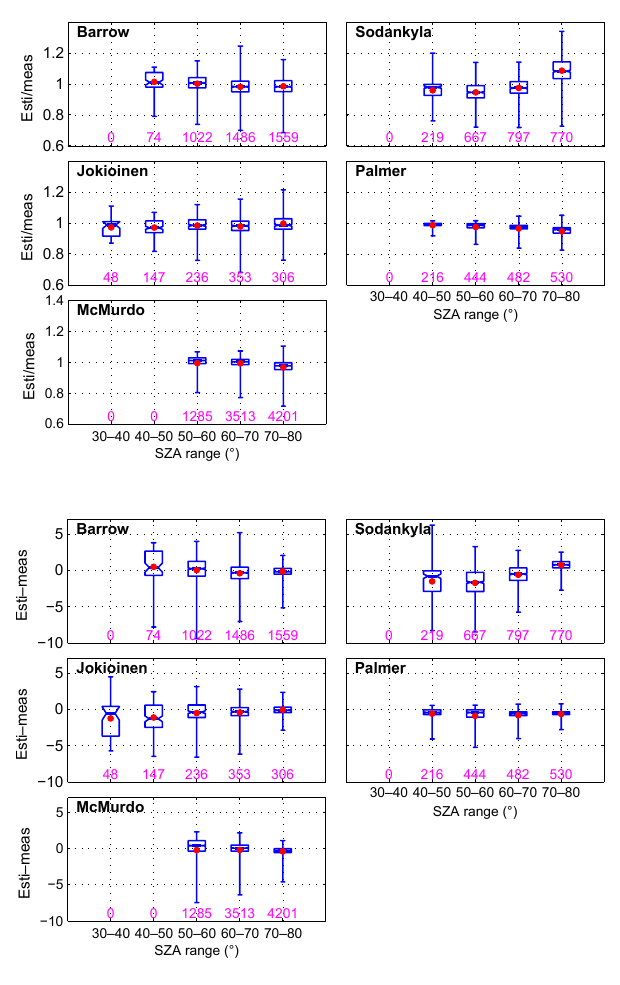
Figure 3. Dependence of ratio (top) of the estimated (esti) to the measured (meas) UV-A irradiances for each station and the differ- ence between the estimated and measured (bottom) UV-A irradi- ances for each station as a function of SZA range. The red dots indicates the mean; the limits of the boxes are the first, second (me- dian) and third quartiles. The lower whisker is the minimum and the upper one is the maximum. The pink number is the number of data in a single SZA